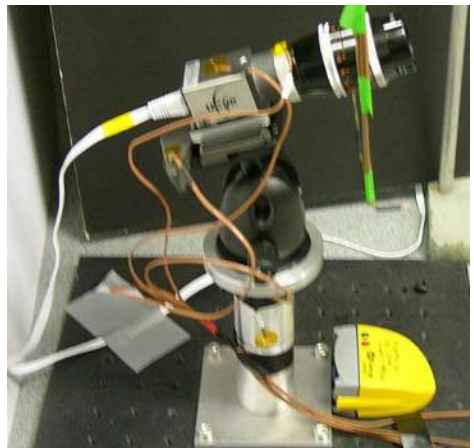
Figure 7. An IDS  Eye 5480CP-M-GL camera fitted with a Kern 75 mm lens and thermocouples. An environmental data logger can be seen at the bottom of the image.